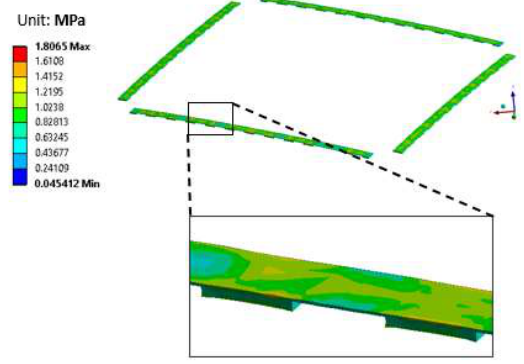
Figure 15. Von Mises stress distribution of the solder joint area.